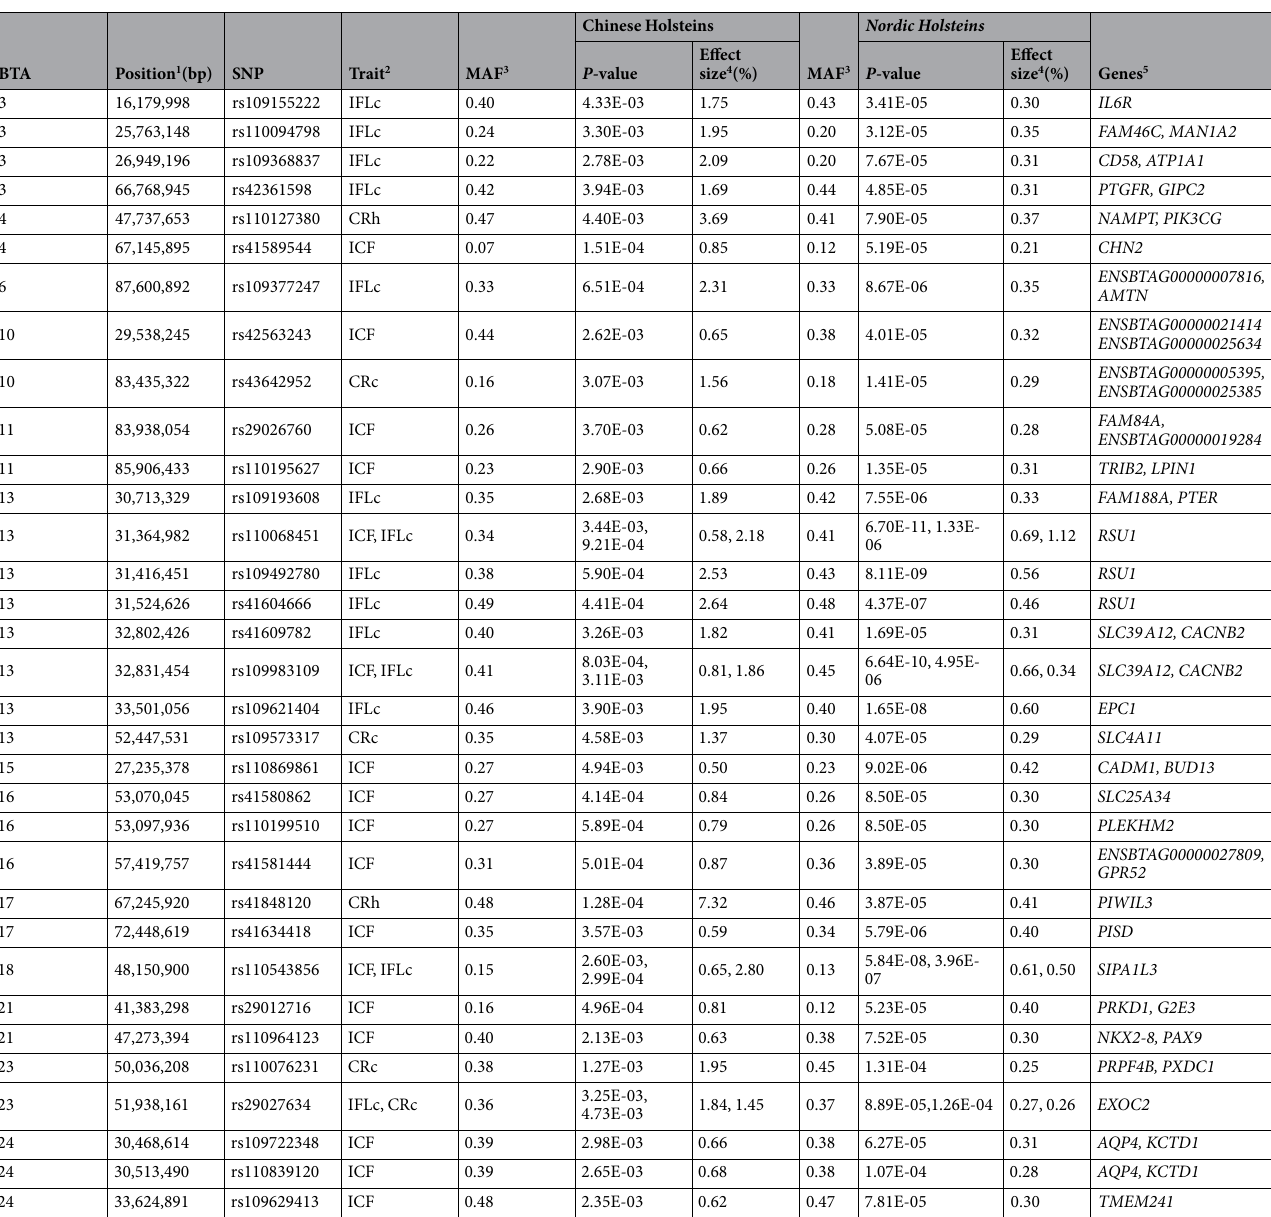
Table 2. The SNPs associated with female fertility traits detected by validating candidate SNPs from Chinese Holsteins using Nordic Holstein data. 1 The base pair position in the BTA ( Bos taurus autosome). 2 CRh = conception rate at first insemination in heifers; ICF = interval from calving to first insemination; IFLc = interval from first to last insemination in cows; CRc = conception rate at first insemination in cows. 3 Minor allele frequency of the validated SNP. 4 The percentage of genetic variance explained by the most significant SNP. 5 Genes harbor or closest to the significant